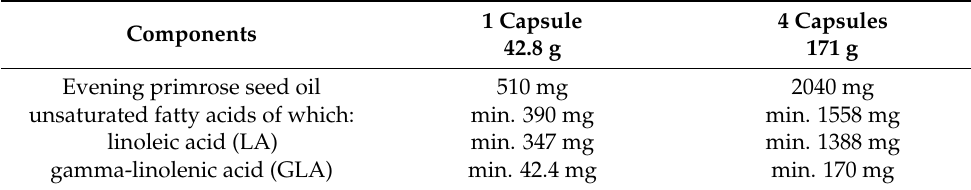
Table 1. Composition of evening primrose oil